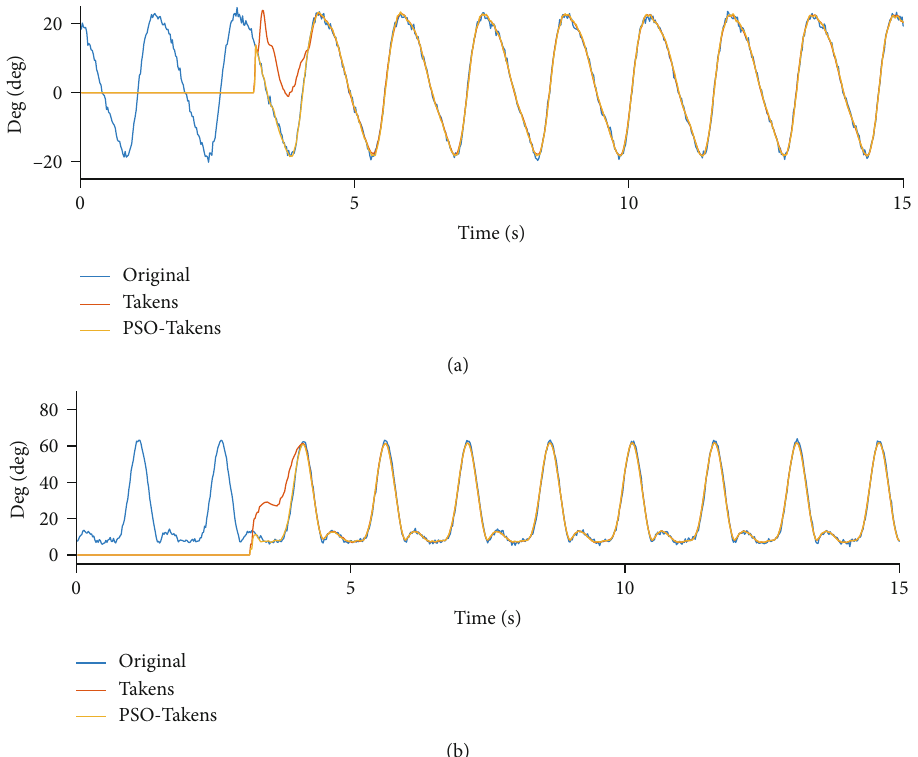
Figure 9: Comparison of Takens and PSO-Takens in prediction of standard gait data. (a) Comparison of hip joint prediction angle. (b) Comparison of knee joint prediction angle.